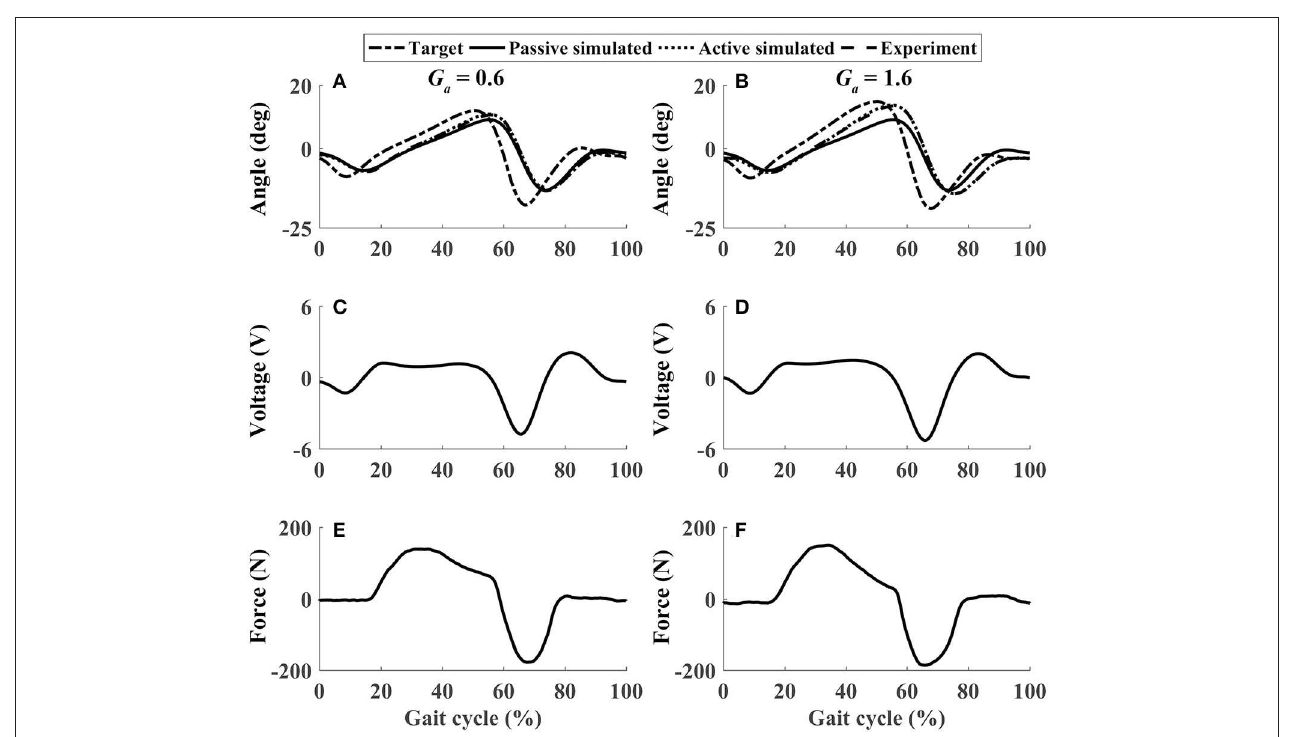
FIGURE 9 | The performance of P1 when he lifted up and pushed down his foot voluntarily within 30–60% and 60–80% of the gait cycle, respectively (Case 2). (A,B) Ankle joint trajectories. (C,D) Input voltage. (E,F) Active force.